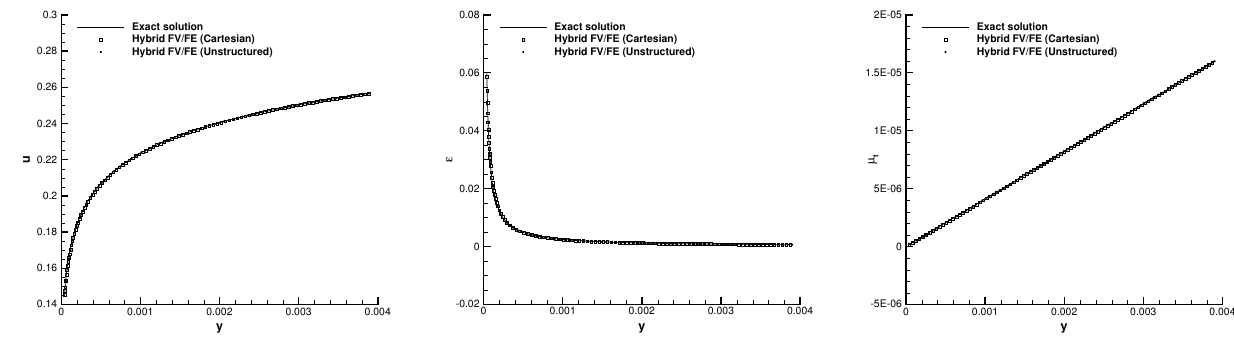
Figure 11. Logarithmic velocity profile obtained with the Cartesian and unstructured hybrid FV/FE scheme at time t = 10 and comparison with the exact solution. Velocity component u ( left ), profile of ε ( center ) and turbulent viscosity µ t ( right ). The logarithmic profile of the velocity and the linear profile of the turbulent viscosity are clearly